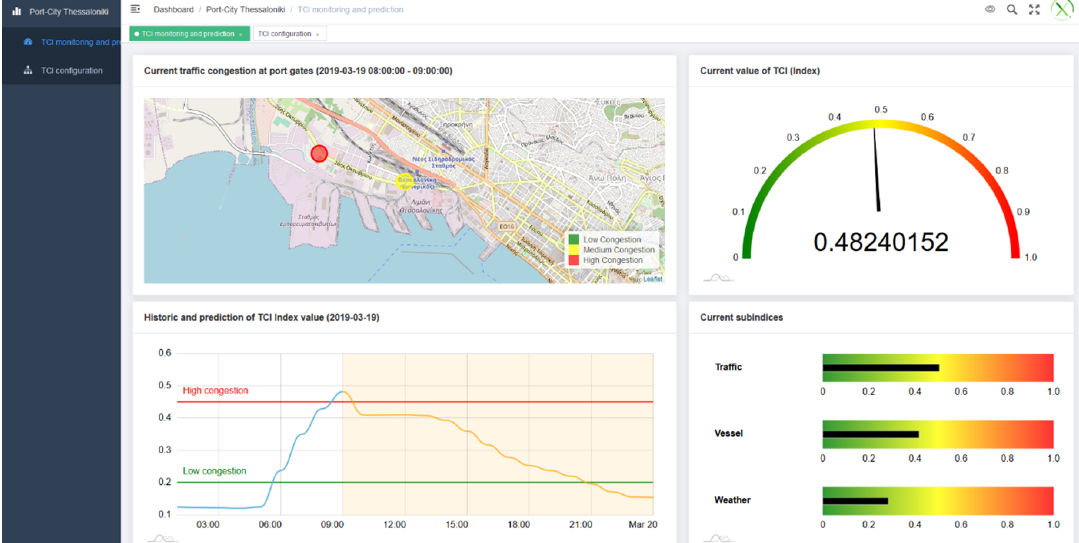
Figure 17. UI dashboard to visualise and interpret the calculation and prediction of the TCI.